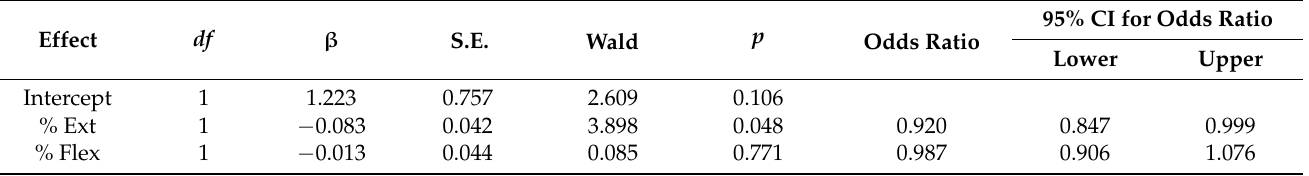
Table 5. Logistic regression model results with bilateral imbalances as predictors.